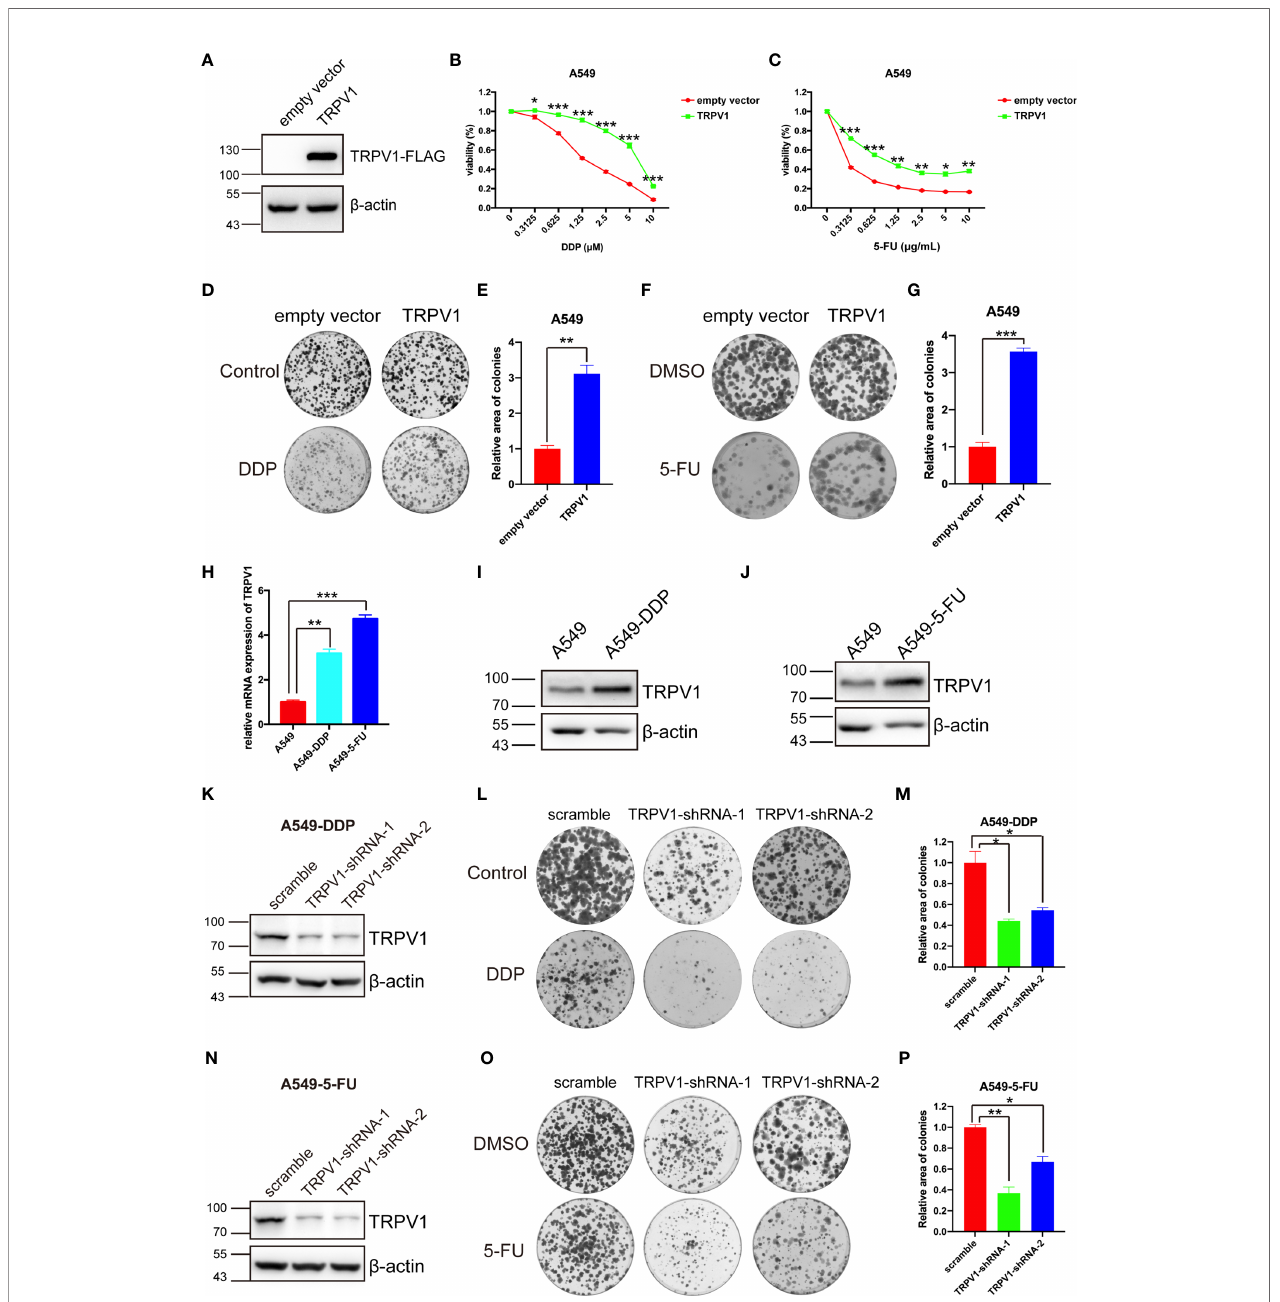
FIGURE 2 | TRPV1 is associated with DDP and 5-FU sensitivity alteration. (A) TRPV1 overexpression in A549 cells was con fi rmed by immunoblotting; b -actin served as the loading control. (B) CCK-8 assay showing that TRPV1 overexpression decreased DDP sensitivity in A549 cells. Cells were treated for 72 h. (C) CCK-8 assay showing that TRPV1 overexpression decreased 5-FU sensitivity in A549 cells. Cells were treated for 72 h. (D) Representative image of a colony formation assay of the effect of TRPV1 overexpression on DDP sensitivity in A549 cells. Cells were treated with 0.5 m M DDP. (E) Statistical analysis of C. (F) Representative image of a colony formation assay of the effect of TRPV1 overexpression on 5-FU sensitivity in A549 cells. Cells were treated with 0.15 m g/mL 5-FU. (G) Statistical analysis of (F) . (H) Quantitative PCR analysis showing that TRPV1 mRNA expression is increased in A549-DDP/5-FU resistant cell lines. (I) Immunoblotting analysis of TRPV1 protein expression in A549-DDP resistant cell lines; b -actin served as the loading control. (J) Immunoblotting analysis of TRPV1 protein expression in A549-5-FU resistant cell lines; b -actin served as the loading control. (K) Immunoblotting analysis of TRPV1 knockdown ef fi ciency; b -actin served as the loading control. (L) Representative image of a colony formation assay of the effect of TRPV1 knockdown on DDP sensitivity in A549-DDP resistance cells. Cells were treated with 4 m M DDP. (M) Statistical analysis of L. (N) Immunoblotting analysis of TRPV1 knockdown ef fi ciency; b -actin served as the loading control. (O) Representative image of a colony formation assay of the effect of TRPV1 knockdown on 5-FU sensitivity in A549-5-FU resistance cells. Cells were treated with 3.5 m g/mL 5-FU. (P) Statistical analysis of O. Three independent experiments were performed. Data represent mean ± SEM; * P < 0.05. ** P < 0.01. *** P <